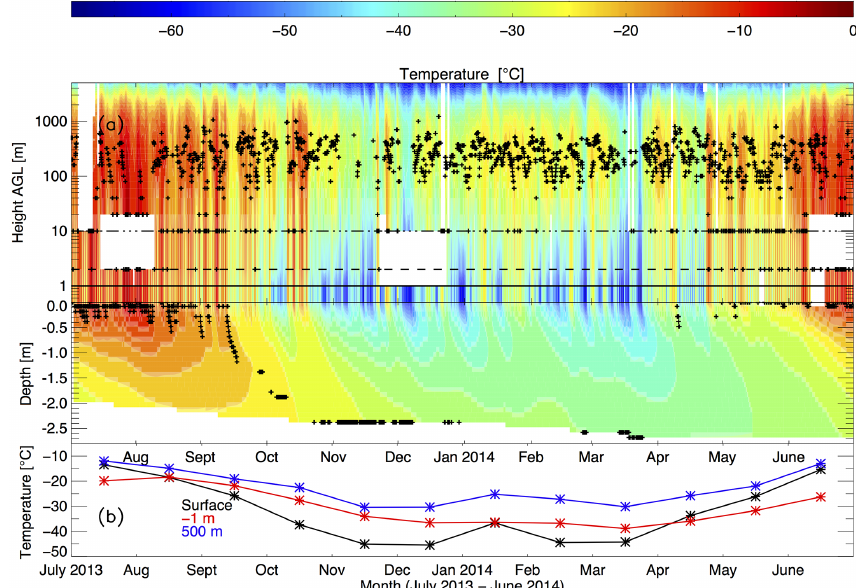
Figure 1. Temperature evolution from 1 July 2013 to 30 June 2014. (a) Values between the solid horizontal lines indicate surface temperatures ( T surf ). The dashed (dashed-dotted) line at 2m (10m) level is NOAA/GMD measurements, and that from 20m to 5kma.g.l. is derived from twice-daily radiosoundings. The height scale above ground level is logarithmic to emphasize the near-surface values where the atmospheric and GIS are physically coupled. Subsurface temperatures are on a linear scale. White areas indicate periods of data gaps and black symbols indicate the height of the maximum temperature in each profile. (b) Monthly mean temperatures at 500m, T surf , and −